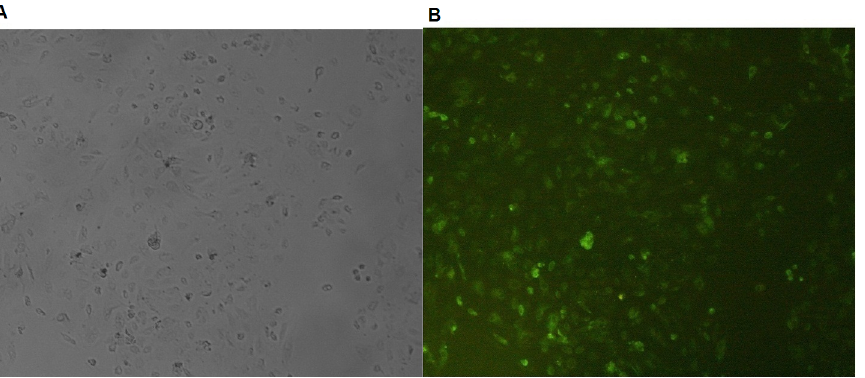
Figure 2. The fluorescence intensity in IMCD cells transfected with adenovirus vectors. IMCD cells were transfected with vehicle adenovirus vectors and Ad-CMV-CYP2C23-EGFP (green) at MOI of 100. Fluorescence intensity was observed at 24 h post-transfection ( 6 10). (A)